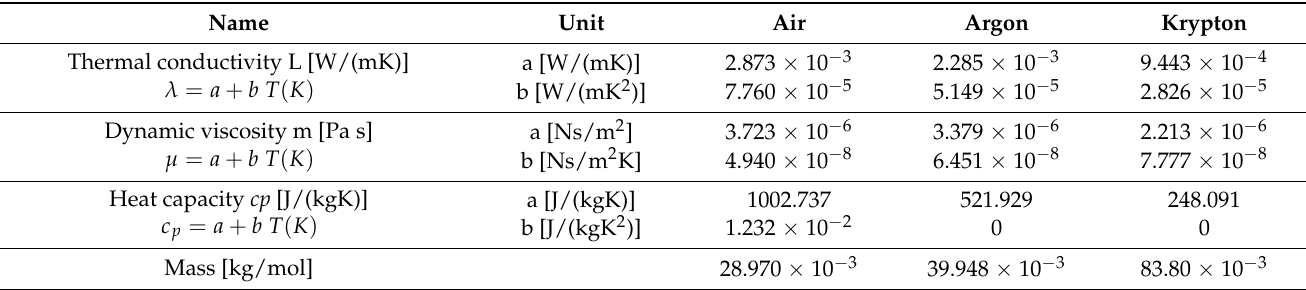
Table 2. Properties of fill gases